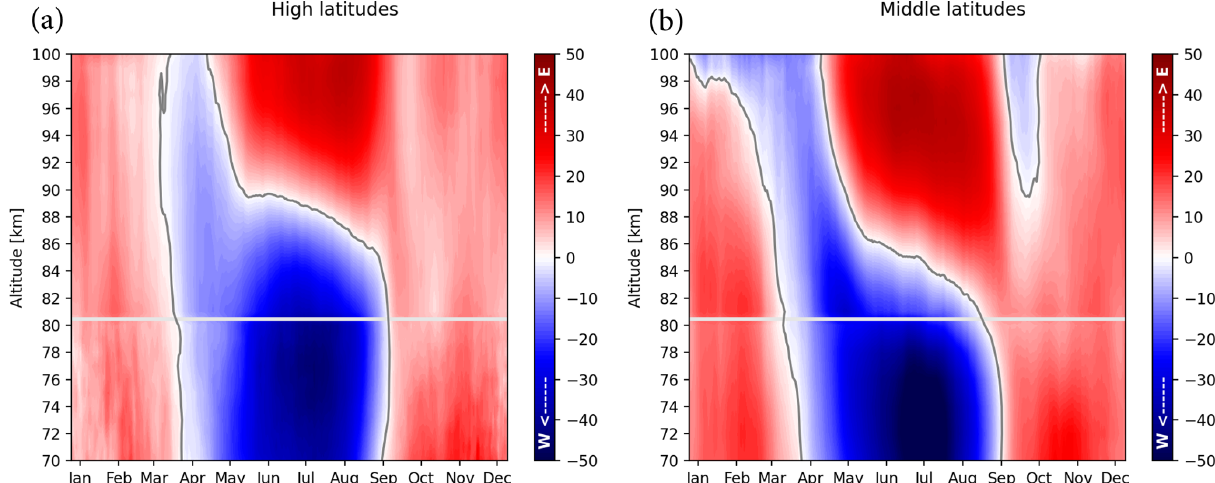
Figure 1. Combined mean zonal wind climatologies at (a) high and (b) middle latitudes. High-latitude values above 81–100km depict the combination of SMRs at Andenes and Tromsø, while below (i.e., 70–80km) the climatology comes from the Saura PRR. The middle- latitude values are divided in the same altitude range with SMRs at Juliusruh and Collm (81–100km) and Juliusruh PRR for lower altitudes (70–80km). The grey line shows the zero wind line.